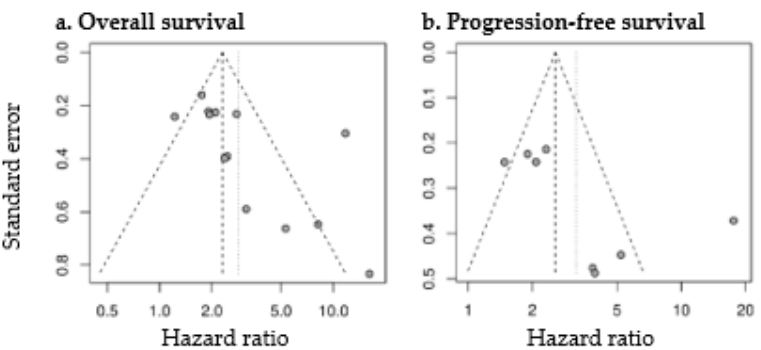
Figure 7. Funnel plots of studies assessing the prognostic value of MTV for OS ( a ) and PFS ( b ).